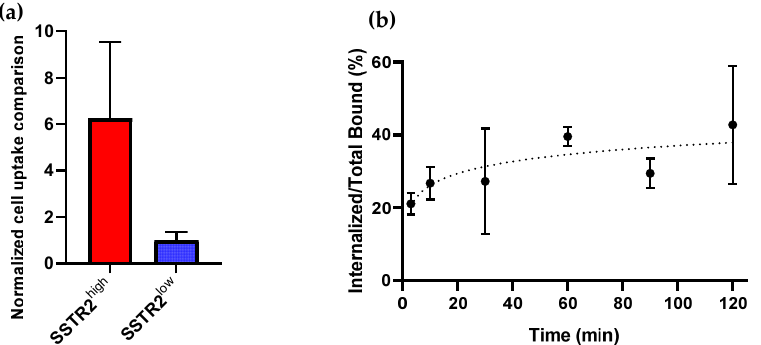
Figure 2. In vitro cell assays of [ 64 Cu]Cu-DOTA-PEG 3 -TZ(PEG 4 -Octr)-PEG 2 -Trz-PEG 3 -Val-Cit- pABOC-FTY720: ( a ) Normalized SSTR2-selective uptake of [ 64 Cu]Cu-DOTA-PEG 3 -TZ(PEG 4 -Octr)- PEG 2 -Trz-PEG 3 -Val-Cit-pABOC-FTY720 (uptake in SSTR2 low cells was set at 1). ( b ) Internalization of [ 64 Cu]Cu-DOTA-PEG 3 -TZ(PEG 4 -Octr)-PEG 2 -Trz-PEG 3 -Val-Cit-pABOC-FTY720 in SSTR2 high AR42J cells. Data presented as average counts ± s.d. (n = 3).